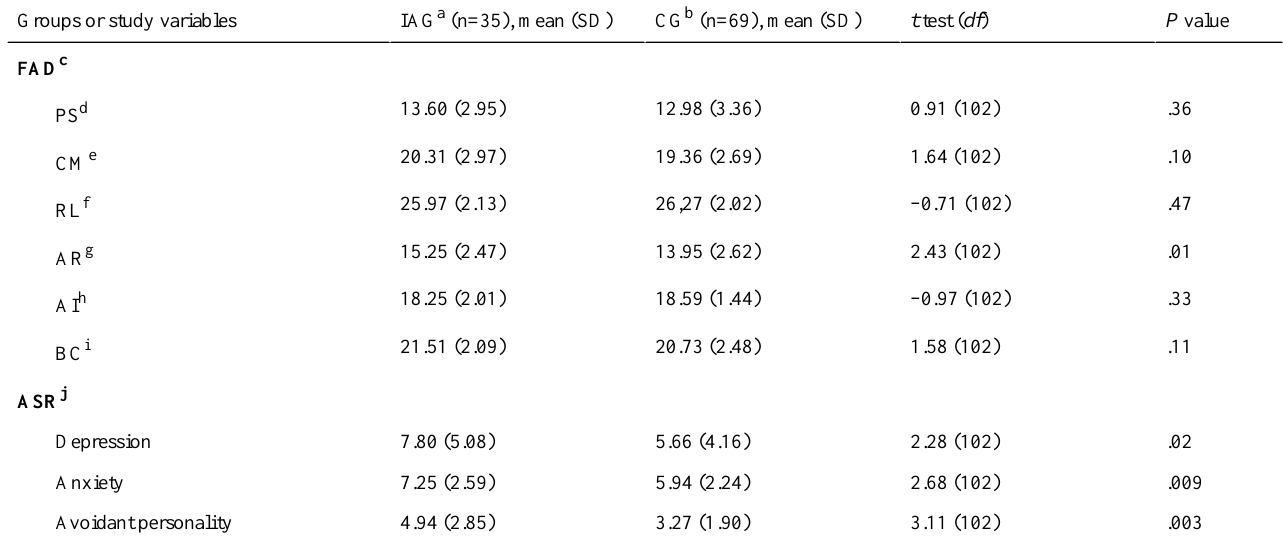
Table 5. t test for family functioning and psychological profile for the 2